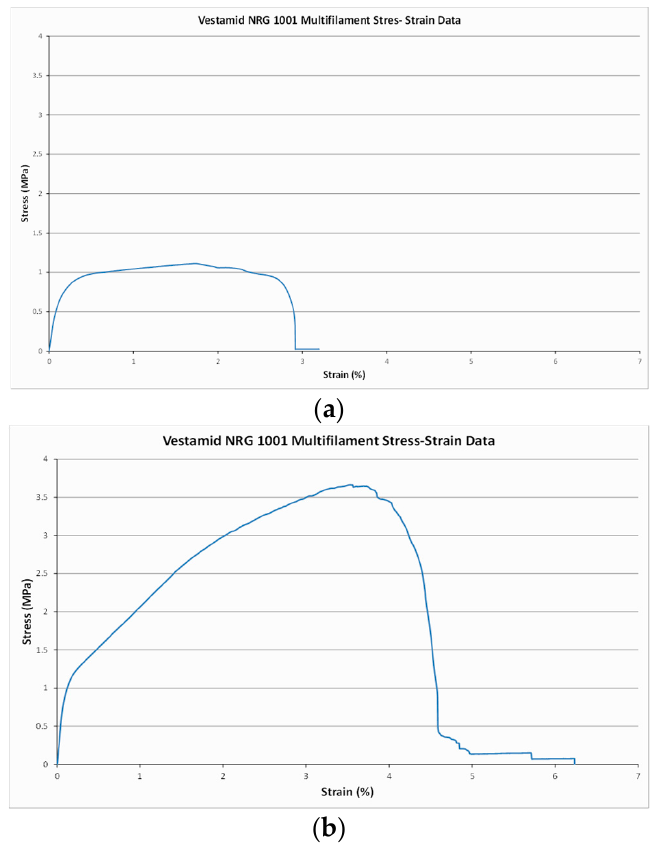
Figure 9. Tensile data displaying the stress-strain curves for ( a ) NRG 1001 monofilament fibres and ( b ) NRG 1001 multifilament fibres.